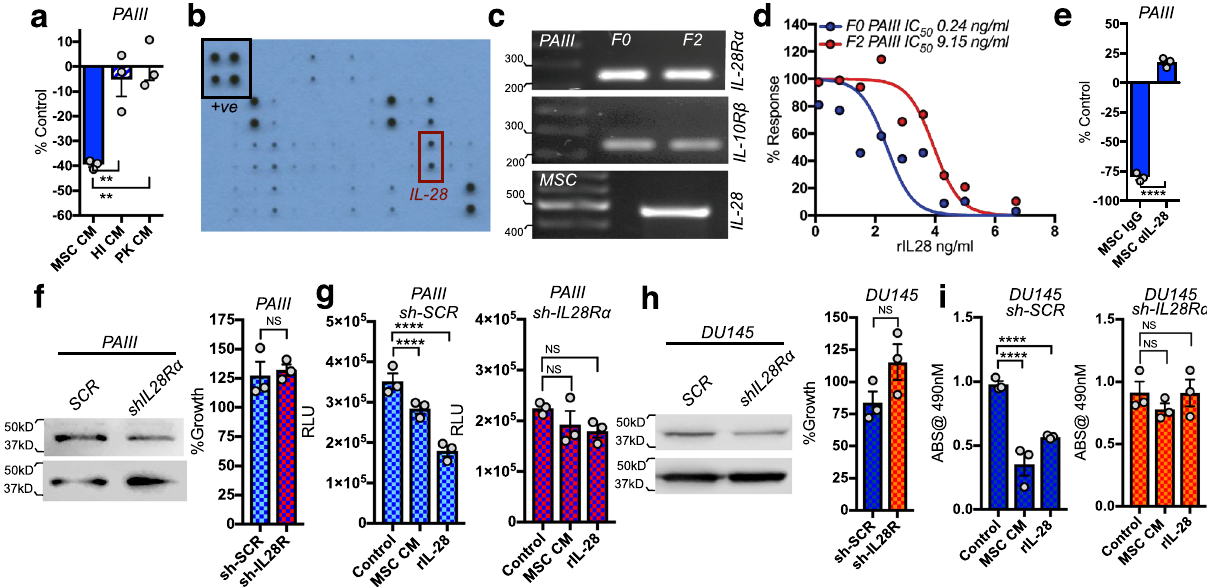
Fig. 5 MSC-derived IL-28 directs PCa apoptosis. a PAIII growth (F0) in response to treatment with MSC CM, heat-inactivated (HI) MSC CM, or proteinase-K (PK) treated MSC CM. b Cytokine Array of MSC CM. Black box indicates positive control ( + ve), red box indicates IL-28. c RT-PCR analysis of PAIII (F0 and F2) of IL28R α , IL-10R β and IL-28 expression. Molecular weights in base pairs are shown. d Growth of PAIII (F0) in MSC CM immune- depleted of IL-28 (MSC α IL-28). IgG was used as negative control (MSC IgG). Growth is expressed as a percentage of non-treated cells. e Treatment of PAIII F0 and F2 cell lines with the indicated concentrations of recombinant IL-28 (rIL-28) for 48 h. f Growth of IL-28R α silenced (sh-IL28R) and scrambled control (sh-SCR) compared to parental PAIII cell lines. g , h Control (sh-SCR) and IL-28R α (sh-IL28R) PAIII and DU145 growth in MSC CM or rIL-28 as measured by luminescence assay and relative light unit (RLU) measurement or MTT assay. Experiments were repeated on at least two ( c , f , h ) or three ( a , e – i ) occasions. Error bars represent the mean ± SEM. Statistical analyses were performed by one-way ANOVA with multiple comparisons at 95% CI ( a , g , i ) or unpaired t -test ( e , f , h ). Asterisks denotes statistical signi fi cance (** p ≤ 0.01, **** p ≤ 0.0001) while NS denotes not signi fi